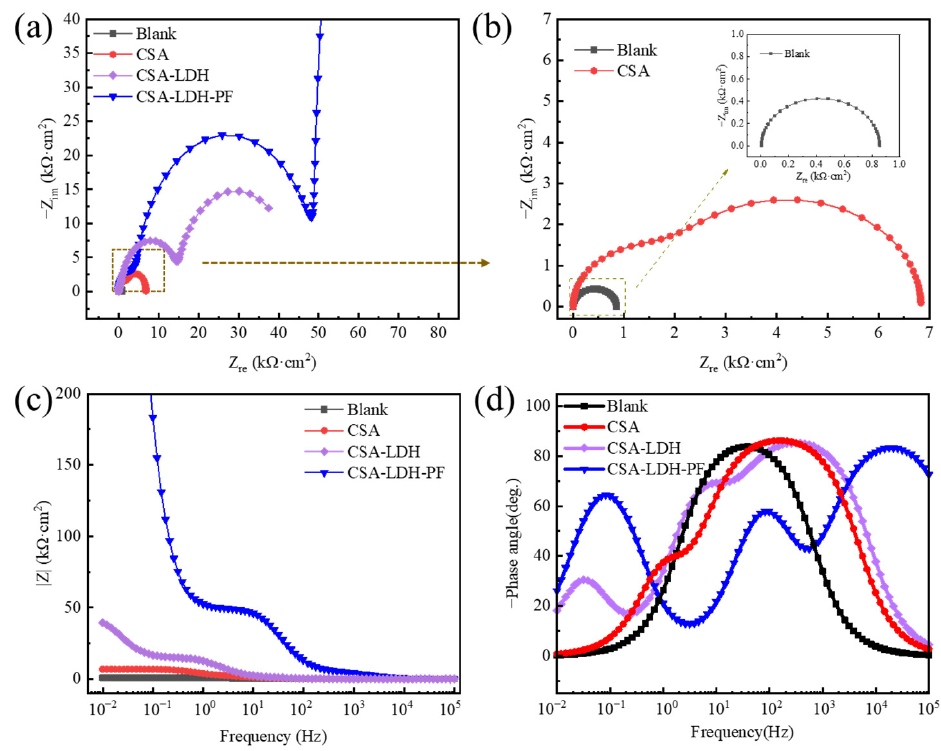
Figure 8. Impedance spectroscopy of the samples with different anodizing and sealing treatments in 3.5 wt.% NaCl solutions. ( a ) Nyquist plot, ( b ) magnified Nyquist plot, ( c ) Bode plot, and ( d ) phase angle plot.